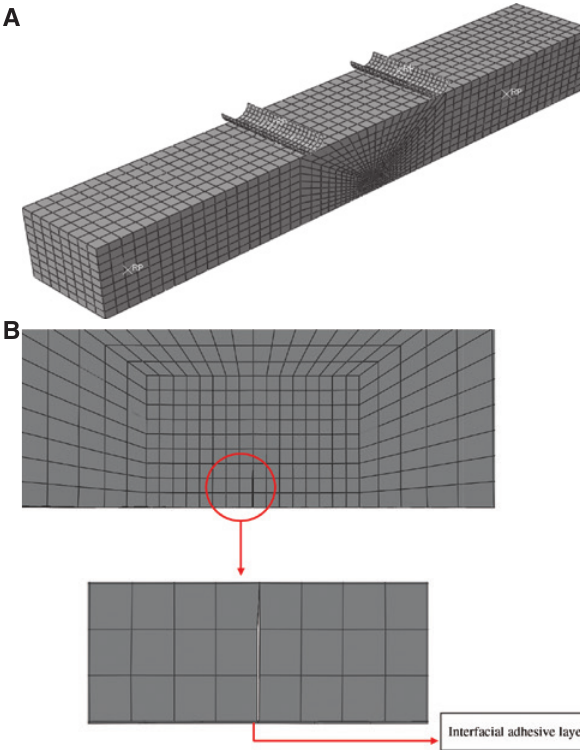
Figure 5: Finite element model of the tested beams and fine mesh generation around the crack tip zone.